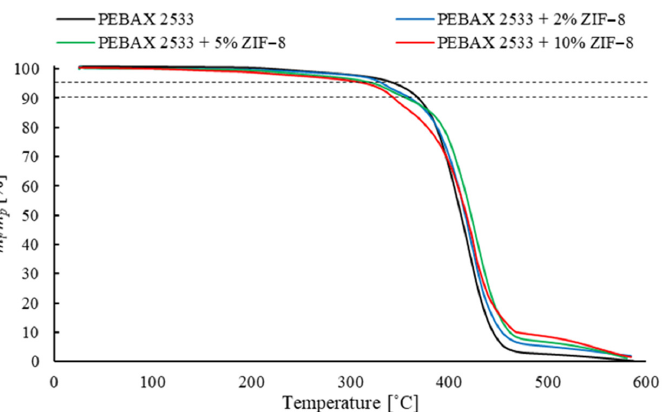
Figure 13. TGA analysis of membranes containing ZIF-8 in different concentrations.